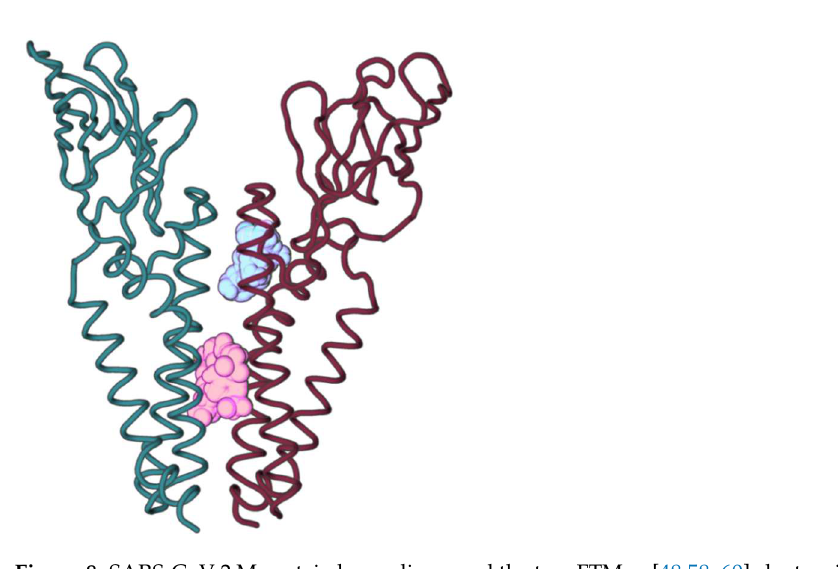
Figure 8. SARS-CoV-2 M protein homodimer and the two FTMap [48,58–60] clusters identified within the interface region. The highest-ranking cluster is represented in teal and the second highest cluster is represented in garnet. Table 7. Summary for predicted interfacial residues that interact with the first probe. Number Residue